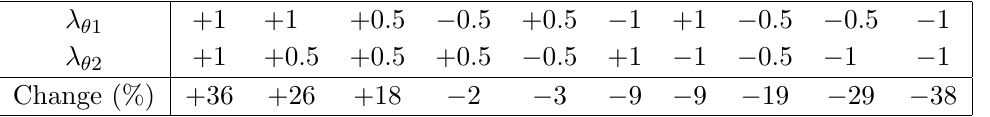
= 0 or (cid:21) = +1 ( (cid:0) 1) corresponds to an isotropic (cid:18) (cid:18) and (cid:21) , are varied simultaneously, and (cid:18) 1 (cid:18) 2 = (cid:21) = (cid:0) 1 and 36% higher for (cid:21) = (cid:21) = +1. This (cid:18) 1 (cid:18) 2 (cid:18) 1 (cid:18) 2